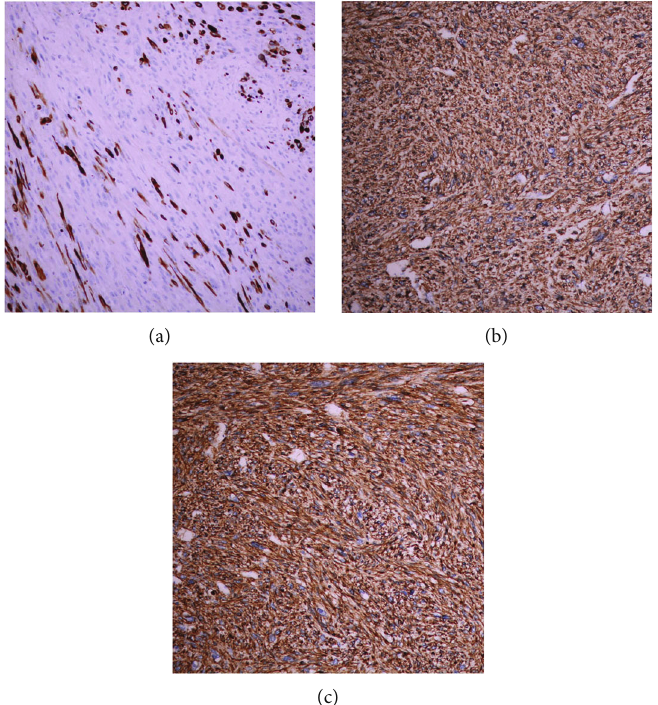
Figure 3: There is positive immunoreactivity for (a) desmin, (b) smooth muscle actin, and (c) caldesmon, which supports the diagnosis of